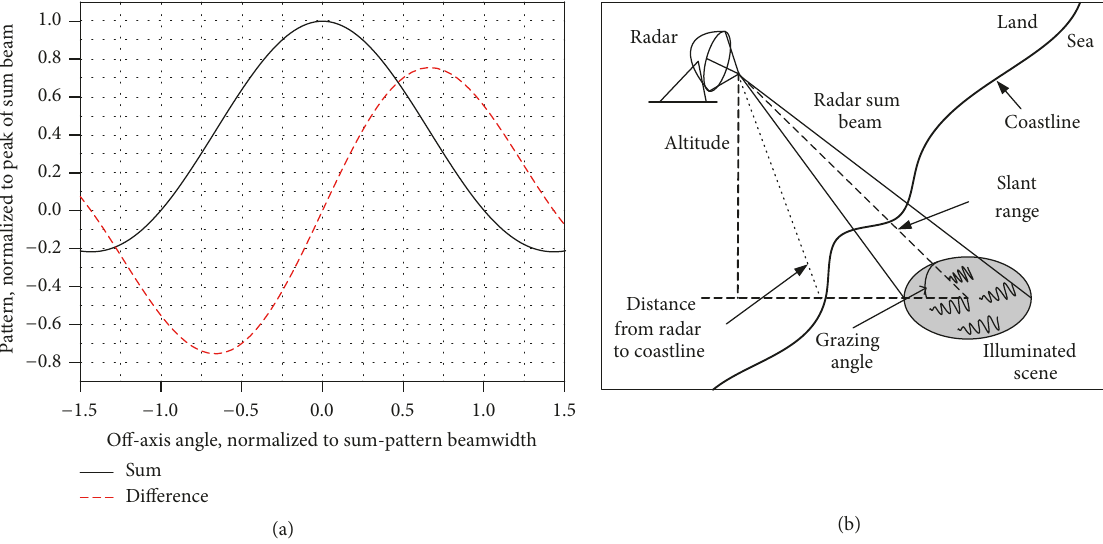
Figure 1: Sketches of the sum and difference patterns and the measurement geometry: (a) sketch of the sum and difference patterns; (b) sketch of the measurement geometry.